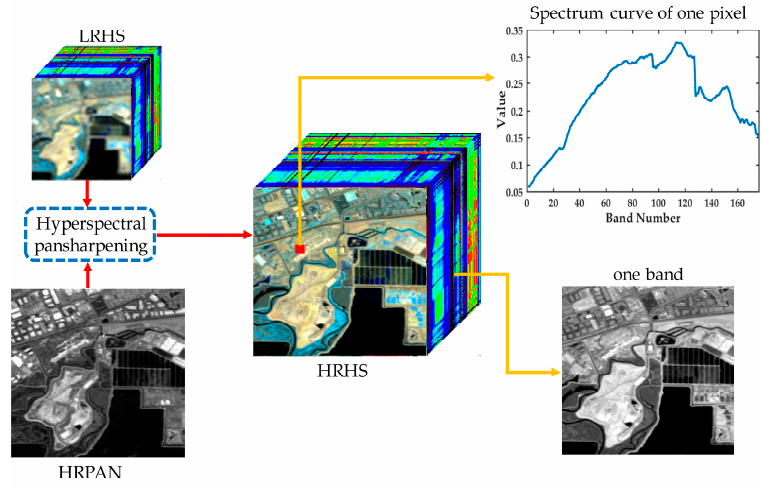
Figure 1. Concept of hyperspectral pansharpening.